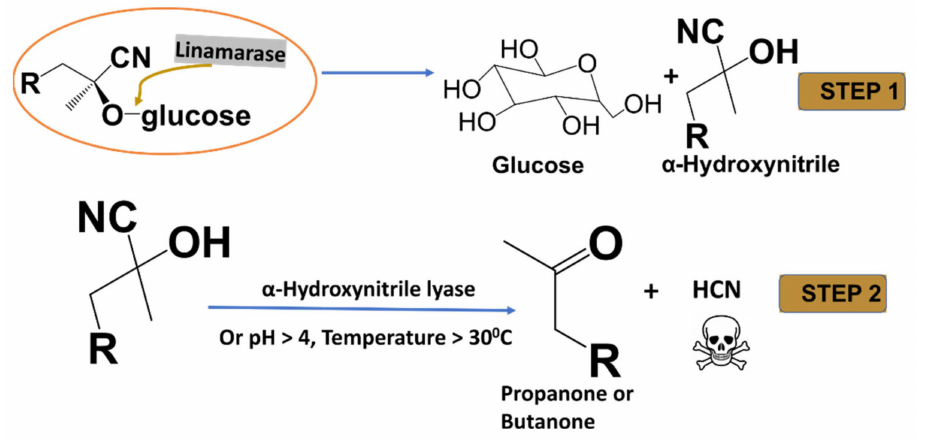
Figure 1. A complete hydrolysis of linamarin and lotaustralin by